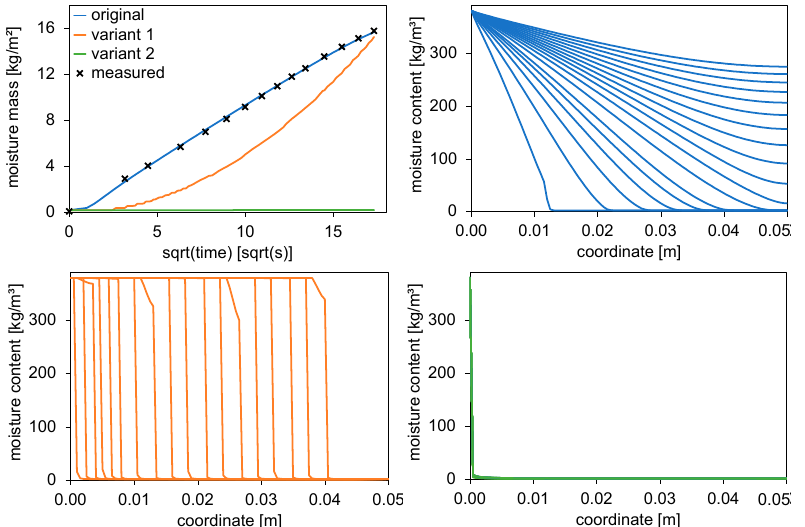
Figure 6. ( top left ) FLoW1D simulations of capillary absorption in the original OPS limestone and two variants, plus original measurements; ( top right , bottom left , bottom right ) FLoW1D-simulated moisture content profiles during capillary absorption, shown every 10 s for the initial minute and then every 20 s for the four remaining minutes.